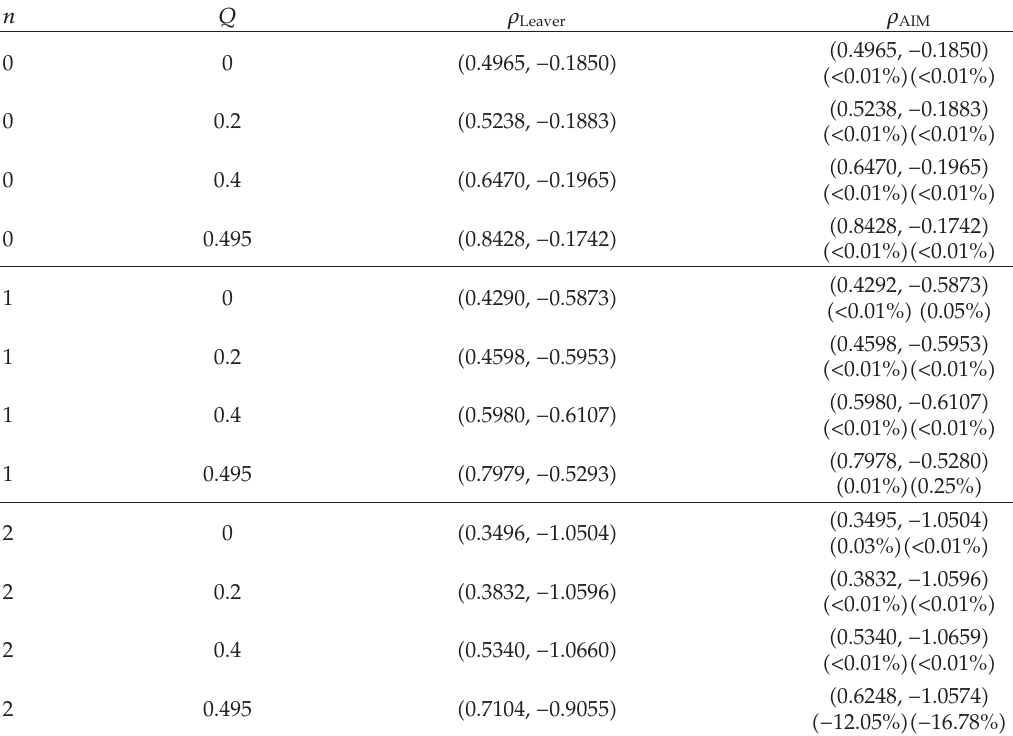
Table 6: Reissner-Nordstr¨om quasinormal frequency parameter values (cid:2) ρ (cid:8) − iω ) for the fundamental (cid:2) n (cid:8) 1 (cid:3) and two lowest overtones for l (cid:8) 1 and i (cid:8)